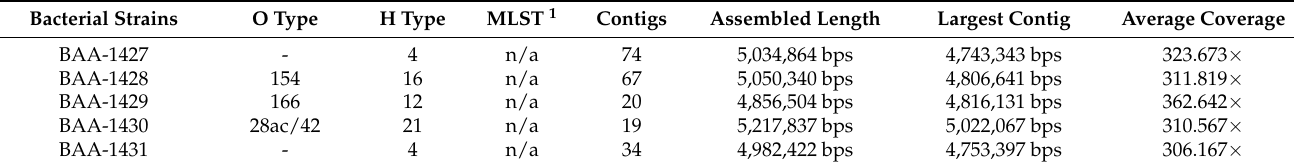
Table 1. Long-read Oxford Nanopore MinION assembly sequence statistics.